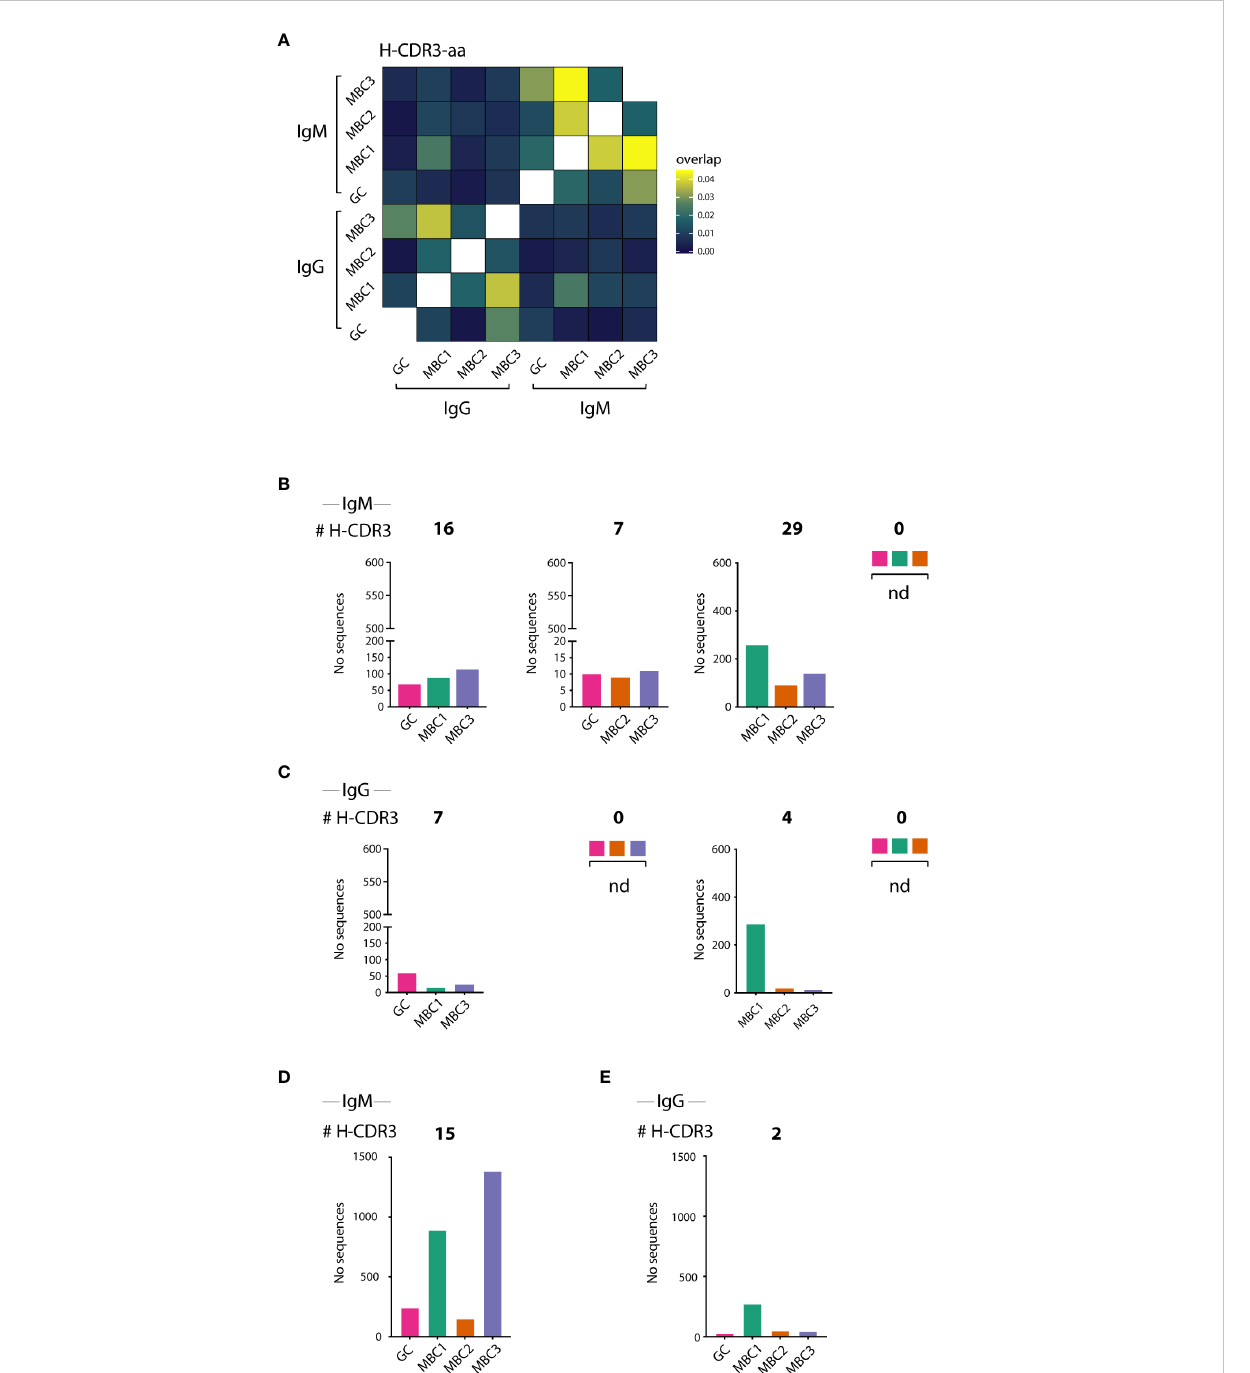
FIGURE 4 H-CDR3 sharing between GC B cells and MBC subsets. (A – E) H-CDR3 sharing analysis of VDJH sequences in sorted IgM- and IgG-expressing GC B cells and MBC subsets. (A) Heatmap shows sharing between IgM and IgG-expressing GC B cells and MBC subsets. (B – E) Graphs show the number of shared H-CDR3s between three (B, D) and four (C, E) populations for IgM and IgG sequences as indicated. Results from a pool of 6